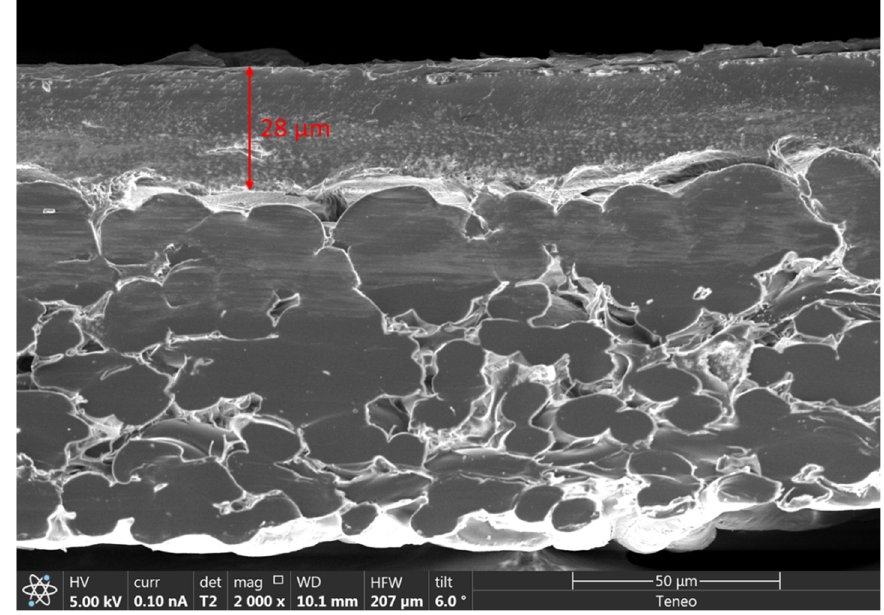
Figure 8. Scanning electron microscopy (SEM) image of the used membrane after operation.